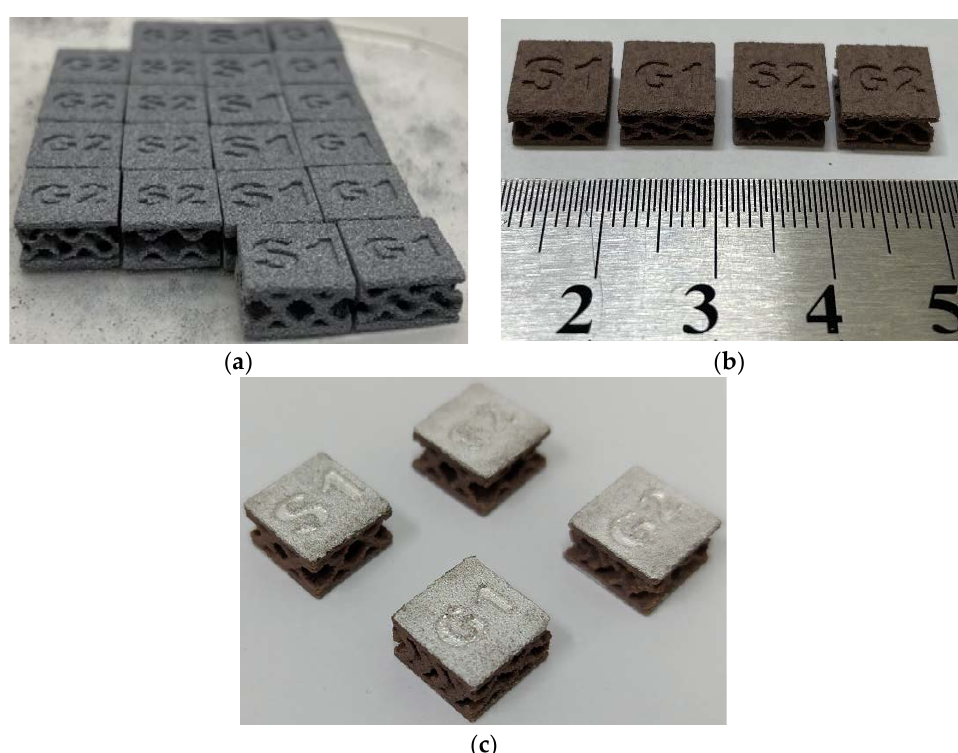
Figure 9. Computer models of TPMS structures of Gyroid- and Schwarz-type topology. Sintering and polarization of TPMS samples were achieved under the same condi- tions as those previously described for the cylindrical samples. Figure 10 shows images of samples at different stages of manufacturing.